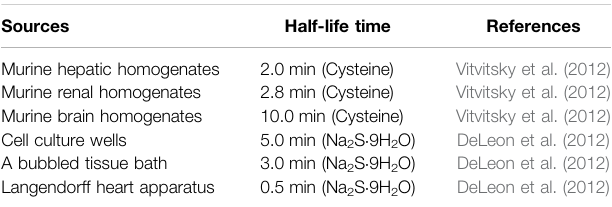
TABLE 1 | Half-life time of